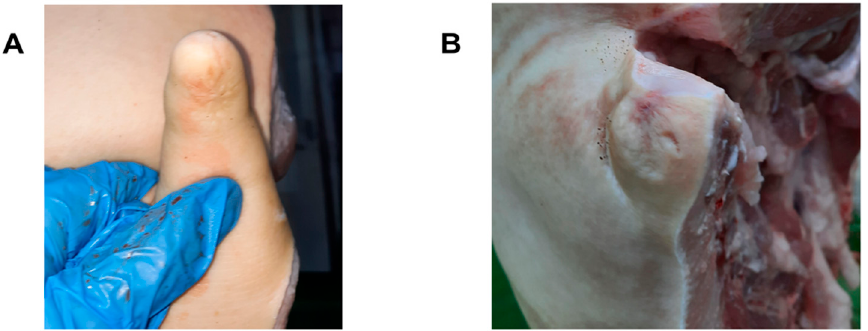
Figure 2. Example pictures of tails scored according to the tail scarring scoring system used (See section Tail Scores for details): ( A ) Score C1—Visible scar with no tissue lost or alteration of tail length (mild scarring); ( B ) Score C2—Visible scar with presumable loss of tail length (severe scar- ring).